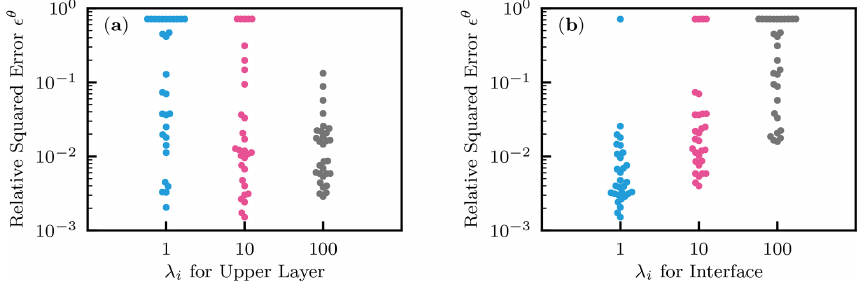
Figure 14. Heterogeneous soil. The effects of the number of interface data points N I . (a) The loss term for the continuity of the residual L I (b) The loss term for the continuity of the water flux L I relative squared error with respect to the volumetric water content (cid:15) θ .